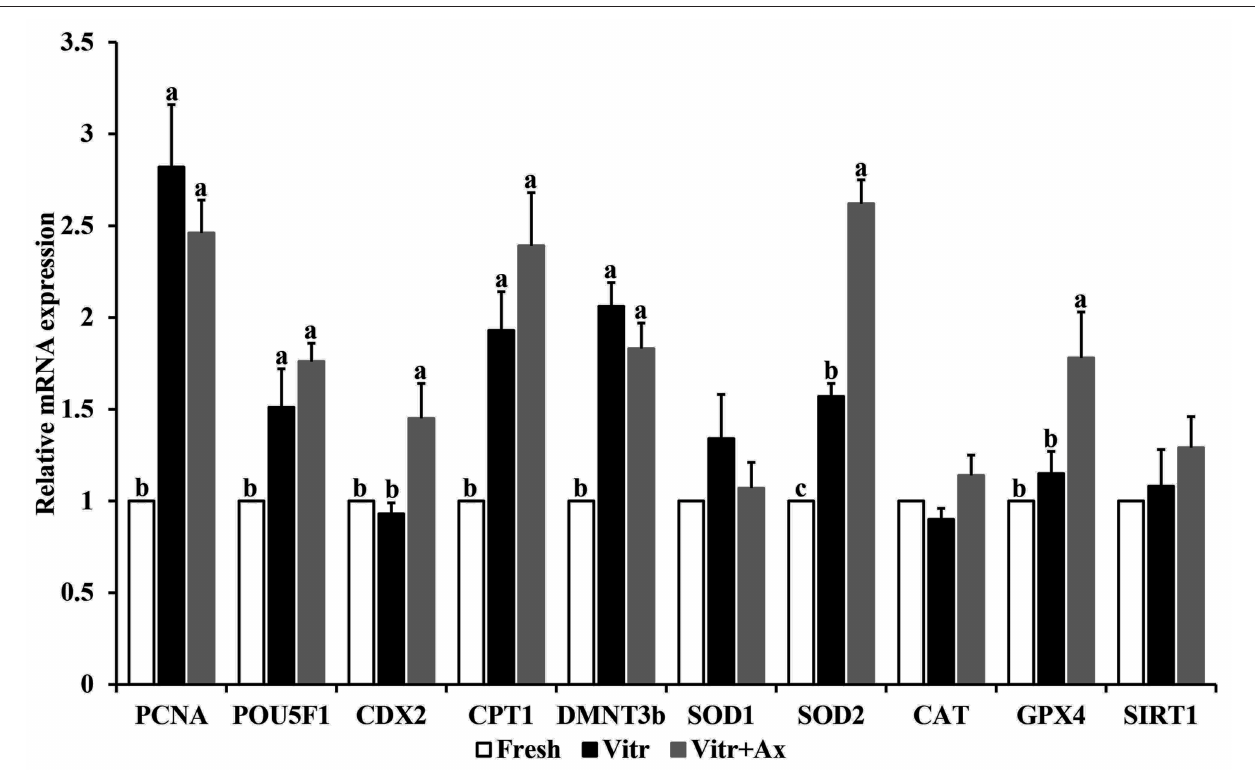
FIGURE 1 | Effects of astaxanthin (Ax) supplementation on mRNA expression levels of genes related to embryo development and oxidative stress in resultant blastocysts. Four replications were performed. Data are the mean ± SEM values. Different superscripts above columns indicate significant differences ( P < 0.05). The three experimental groups: fresh zygotes (Fresh group), vitrified zygotes (Vitr group), and vitrified zygotes cultured with Ax (Vitr + Ax group).